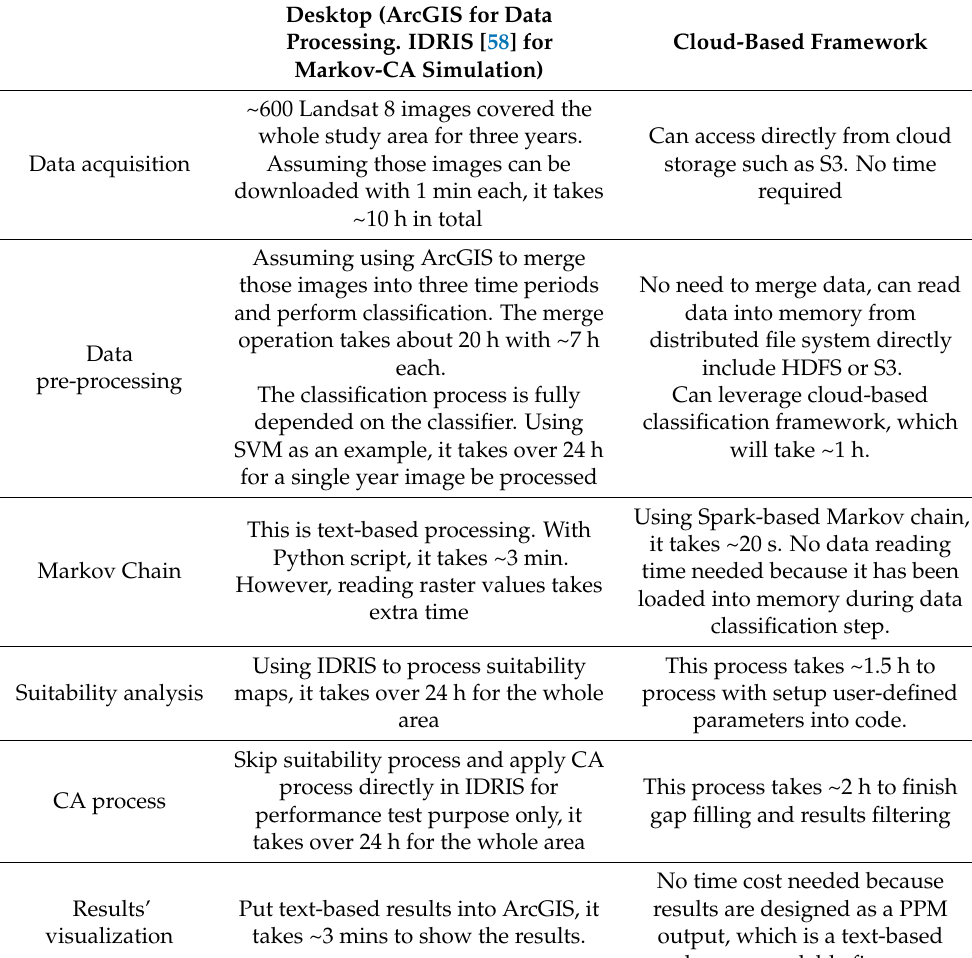
Table 4. Comparison of processing time between cloud-based LULC gap filling with traditional desktop based processing with commonly used